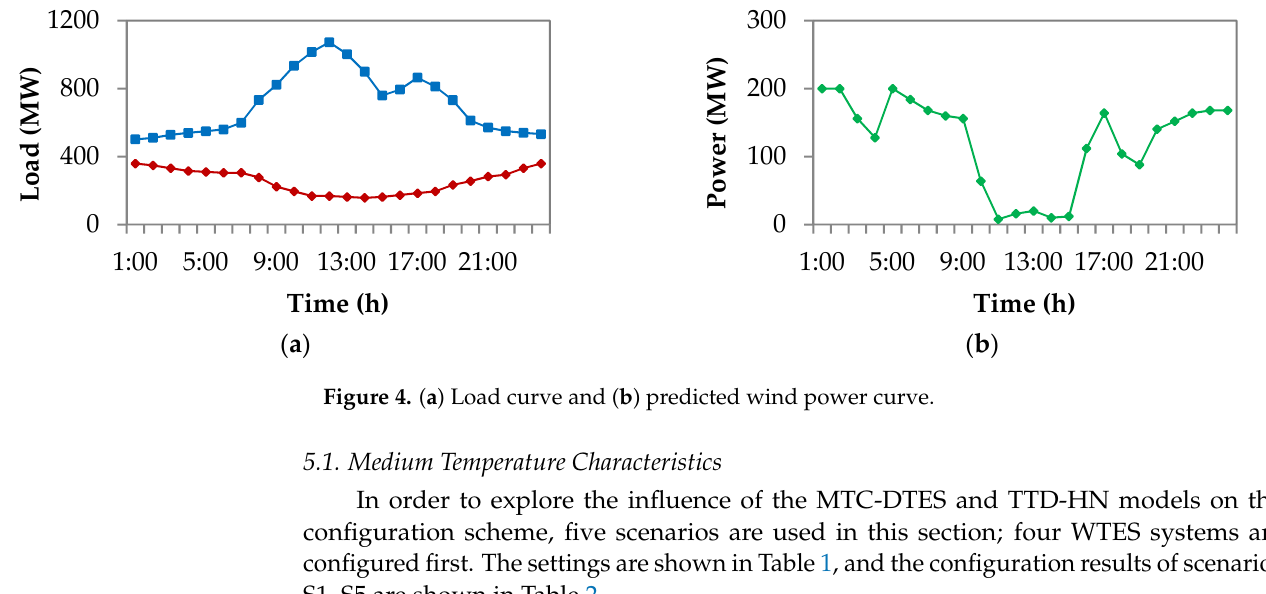
Table 1. Settings for scenarios